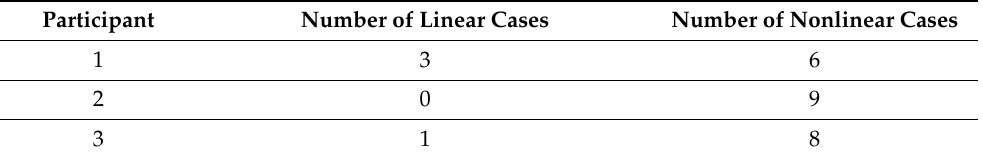
Table 8. Ocular patterns when attending to language-related